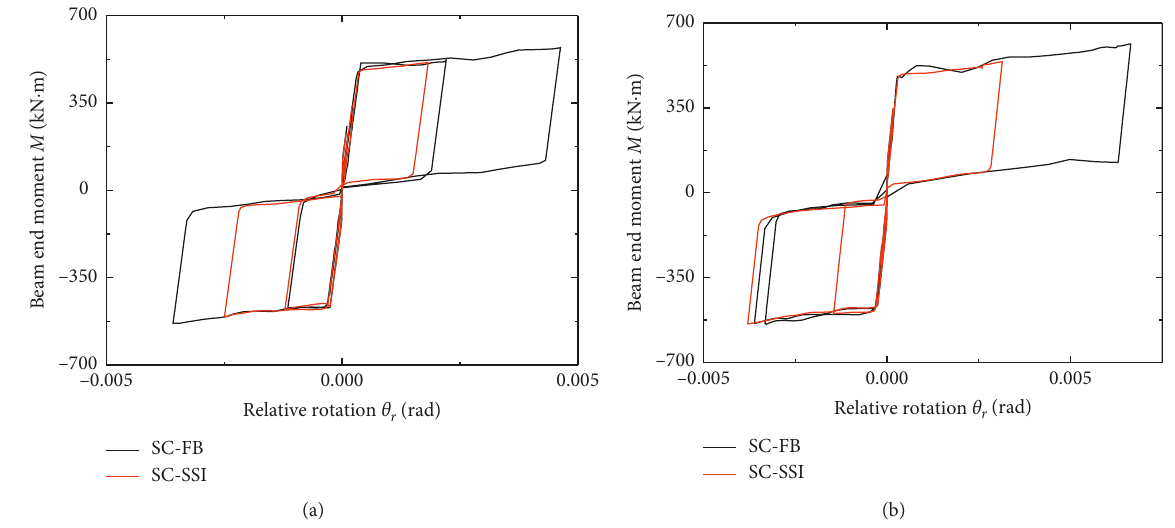
Figure 7: Connection behavior of the SC frames under the LP89slc record scaled to DBE and MCE. (a) DBE. (b)